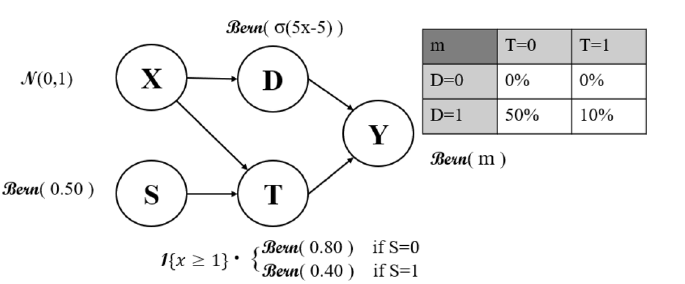
Figure 15. Training data distribution, mortality rates, and testing AUCs across each protected attribute for all patients and patients with HEM/METS, summarized over all five classifiers: AutoInt, LSTM, IMV-LSTM, TCN, and Transformer.